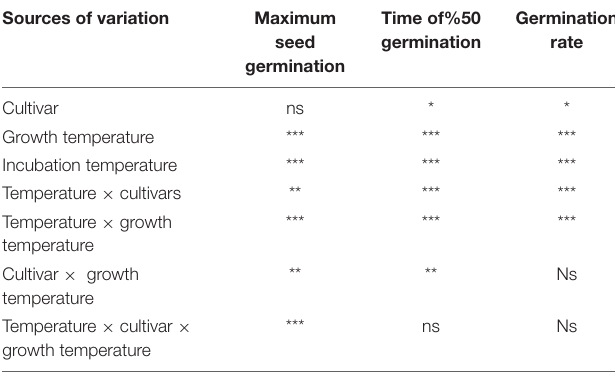
TABLE 3 | Analysis of variation across the temperatures, parental growth temperature, cultivars, and their interaction with maximum seed germination, time to 50% seed germination, and seed germination